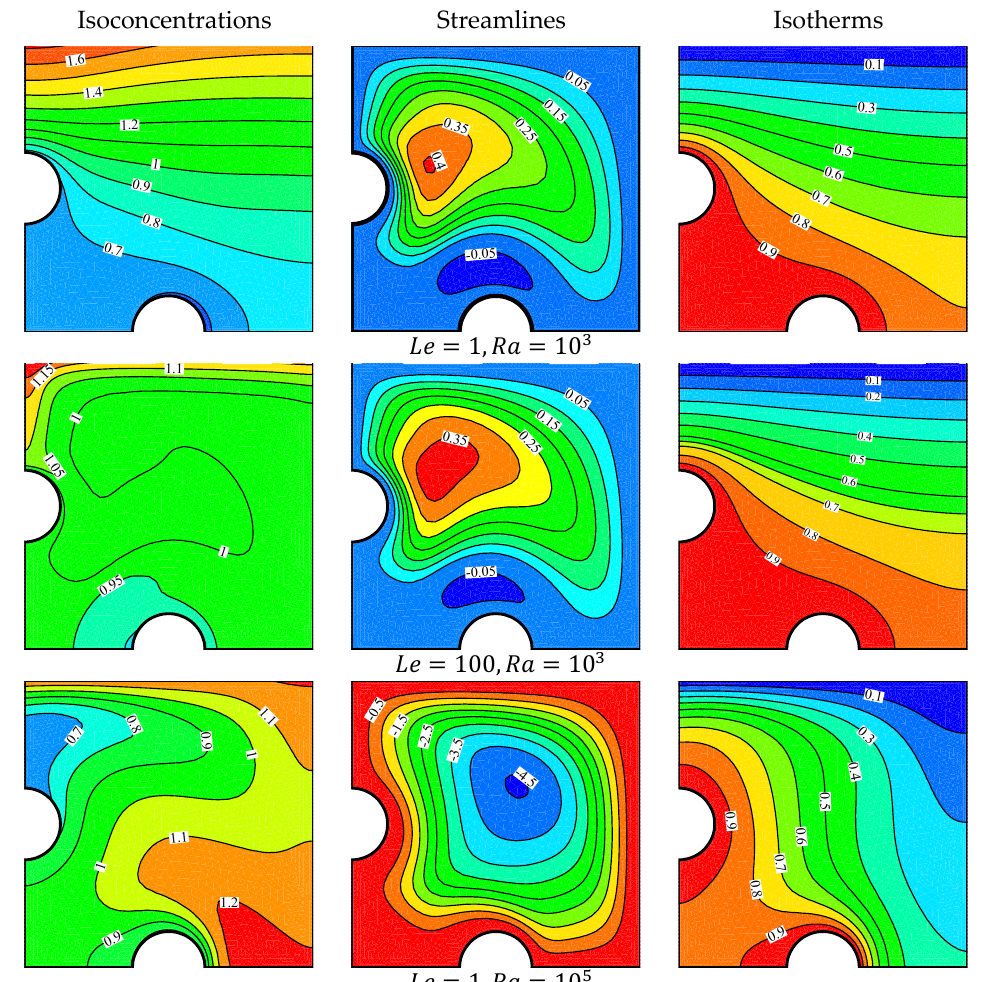
Figure 7. Isoconcentrations, streamlines and isotherms at different Lewis and Rayleigh numbers for 𝛾 (cid:3045) = 1 , 𝑀𝑛 (cid:3033) = 1000 , 𝑁𝑏 = 𝑁𝑡 = 𝑁𝑟 = 0.5, and 𝐻𝑎 = 20 .